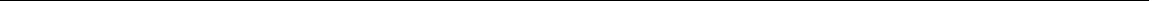
Fig. 2 GSK3 is required for neural crest migration in vivo. a – h mRNA in situ hybridization of Sox10 , which marks migratory neural crest. a , e e9.5 mouse embryos ( n = 3). b – d , f – h e10.5 mouse embryos ( n = 3). a , b , e , f Dorsal views. c , d , g , h Lateral views of e10.5 control embryos. a , b In control